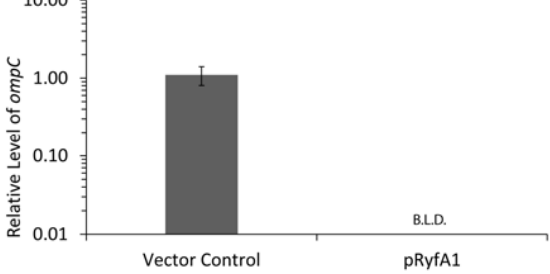
Figure 7. Increased production of RyfA1 results in undetectable levels of ompC transcript. qRT ‐ PCR measuring the relative abundance of ompC transcript levels in S. dysenteriae carrying the RyfA1 producing plasmid pRyfA1 or the vector control following growth in the presence of IPTG. Using the ΔΔ Ct method [24], ompC levels are normalized to that of rrsA in each sample and are expressed relative to a single vector control sample. Data presented are the average of analyses completed in biological triplicate with error bars representing one standard deviation. B.L.D. indicates that the target transcript was below the level of reliable detection.